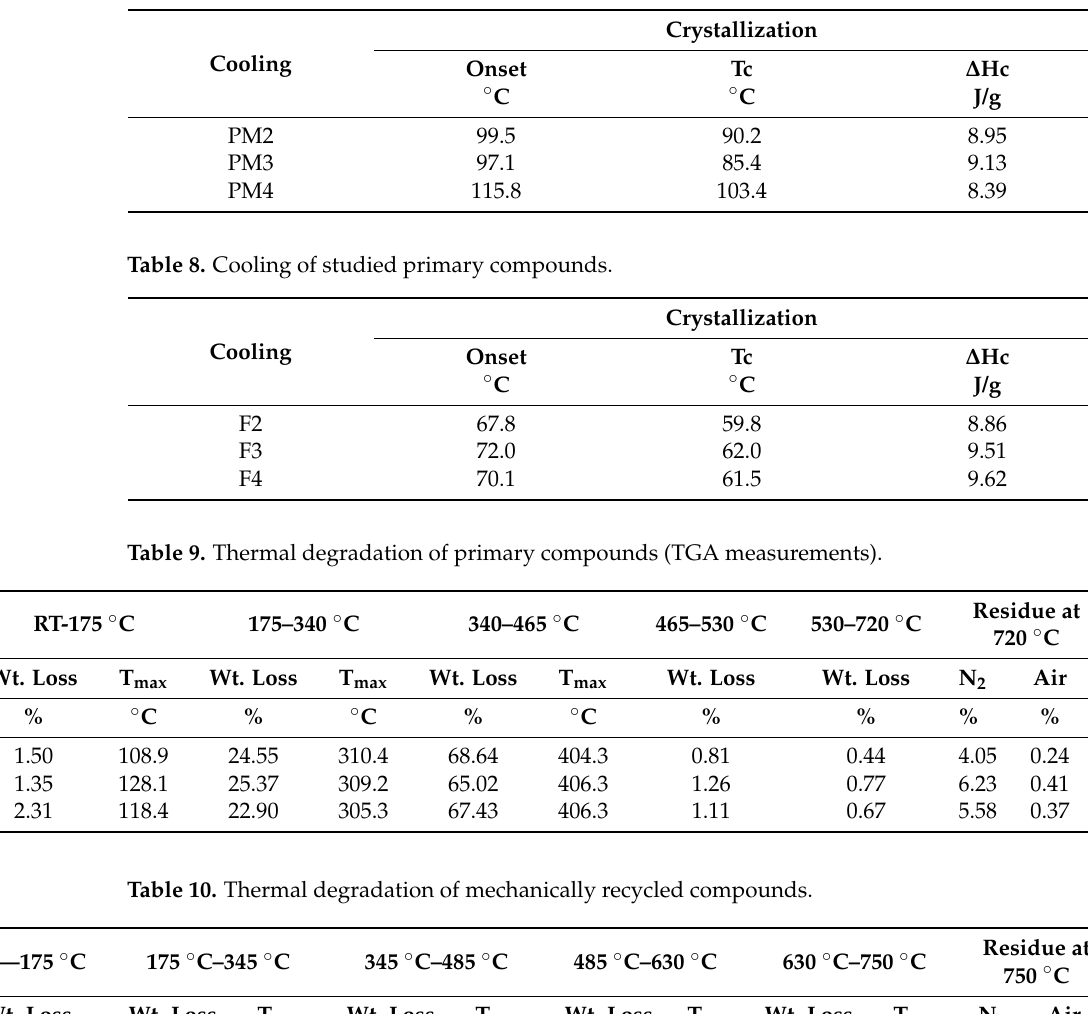
Table 7. Cooling of mechanically recycled compounds.